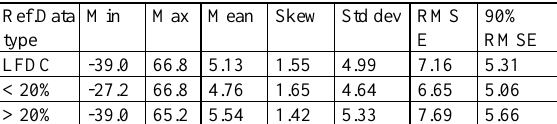
Figure 8. TanDEM-X DEM for open-pit coal mine area (a) DEM obtained on 05-09-2012 and (b) on 10-01-2013, (c) SRTM DEM and (d) Difference between TanDEM-X Jan. 10, 2013 and LFDC DEM. Colour scale is same for all DEMs.